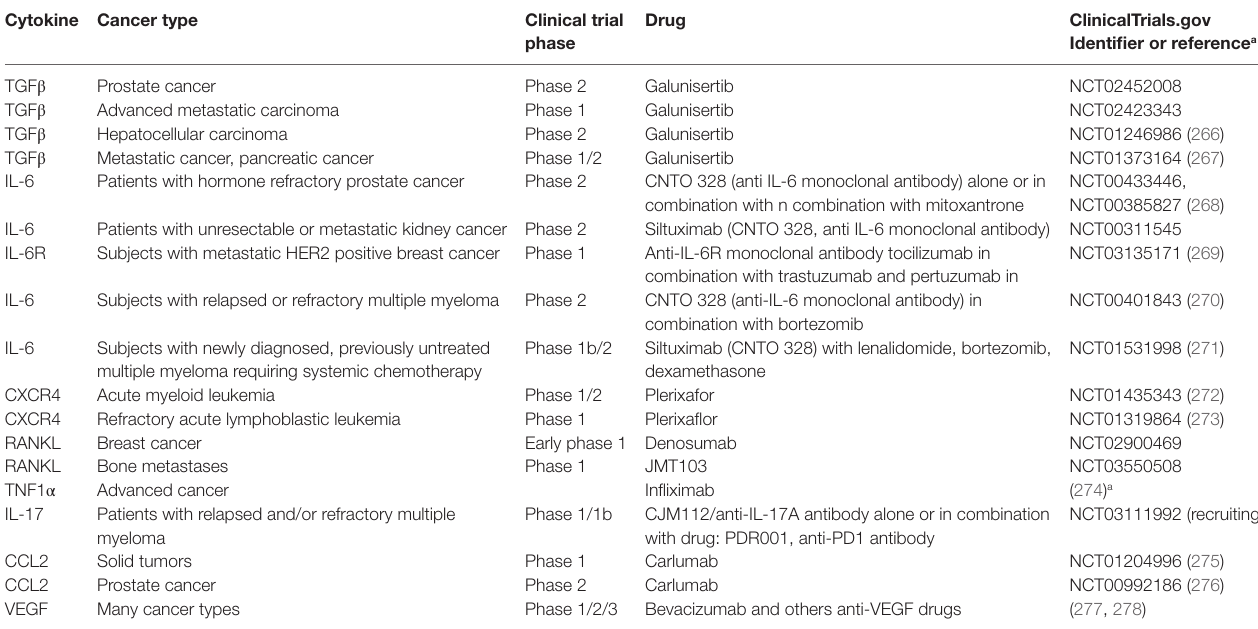
Table 2 | Overview of the last clinical trials that targets cancer-altered cytokines. Cytokine Cancer